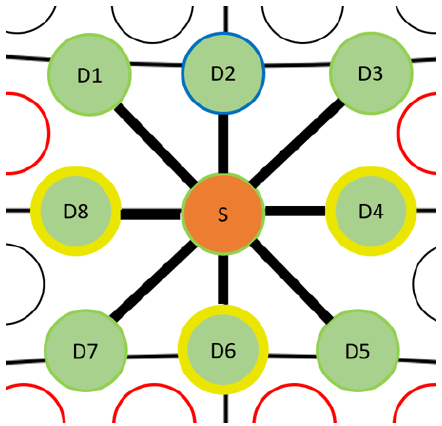
Figure 4. Eight channels montage with one source and eight detectors.